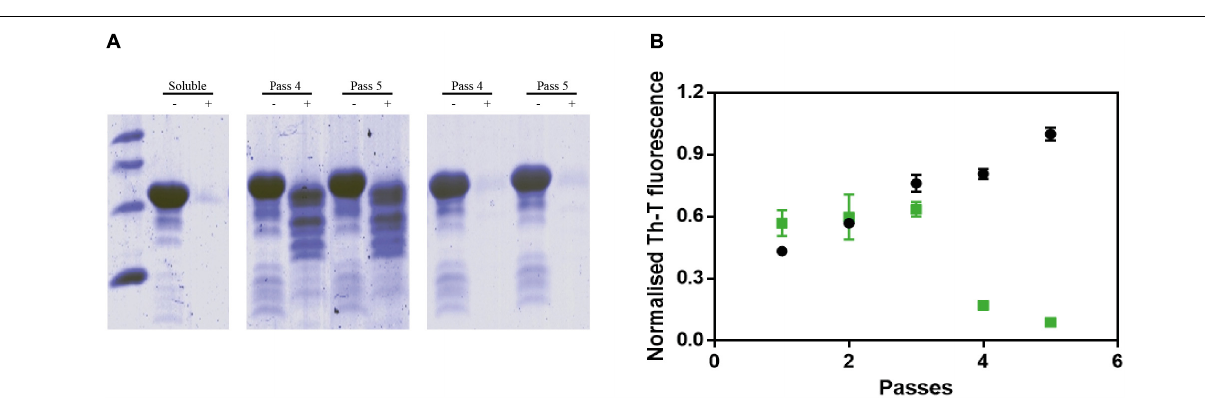
FIGURE 5 | PMCA of α -synuclein in presence of ZPD-2. (A) Tricine–SDS-PAGE gels of untreated (middle) and ZPD-2-treated (right) PMCA samples before (–) and after (+) being digested with proteinase K. (B) Th-T fluorescence of different PMCA cycles of treated (green) and untreated (black) samples. Soluble α -Syn and PMCA steps 4 and 5 are shown. Th-T fluorescence is plotted as normalized means. Error bars are shown as standard errors of mean